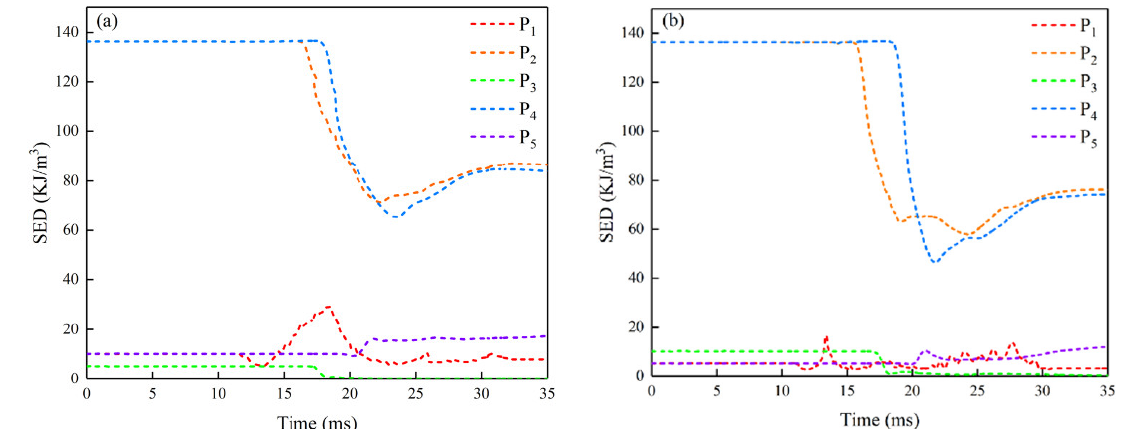
Figure 11. Time history of SED ( a : model I; b : model II).